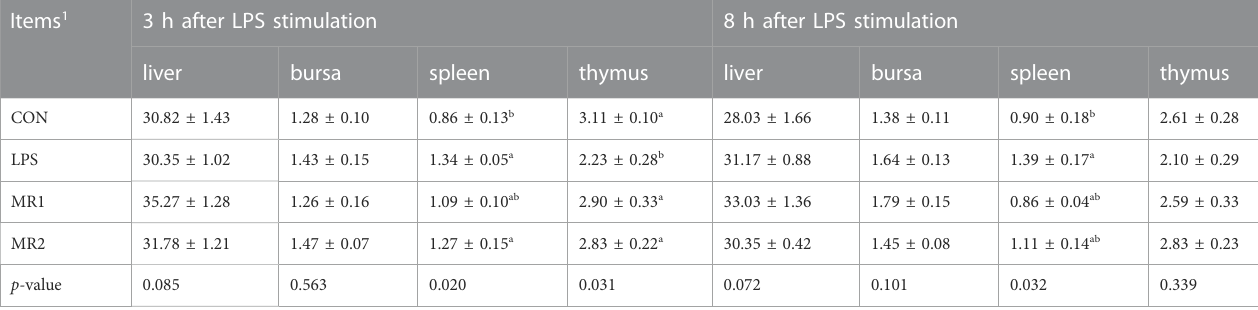
TABLE 4 Effects of dietary methionine restriction on relative organ weigh of LPS-stimulated broilers (g/kg) (n =